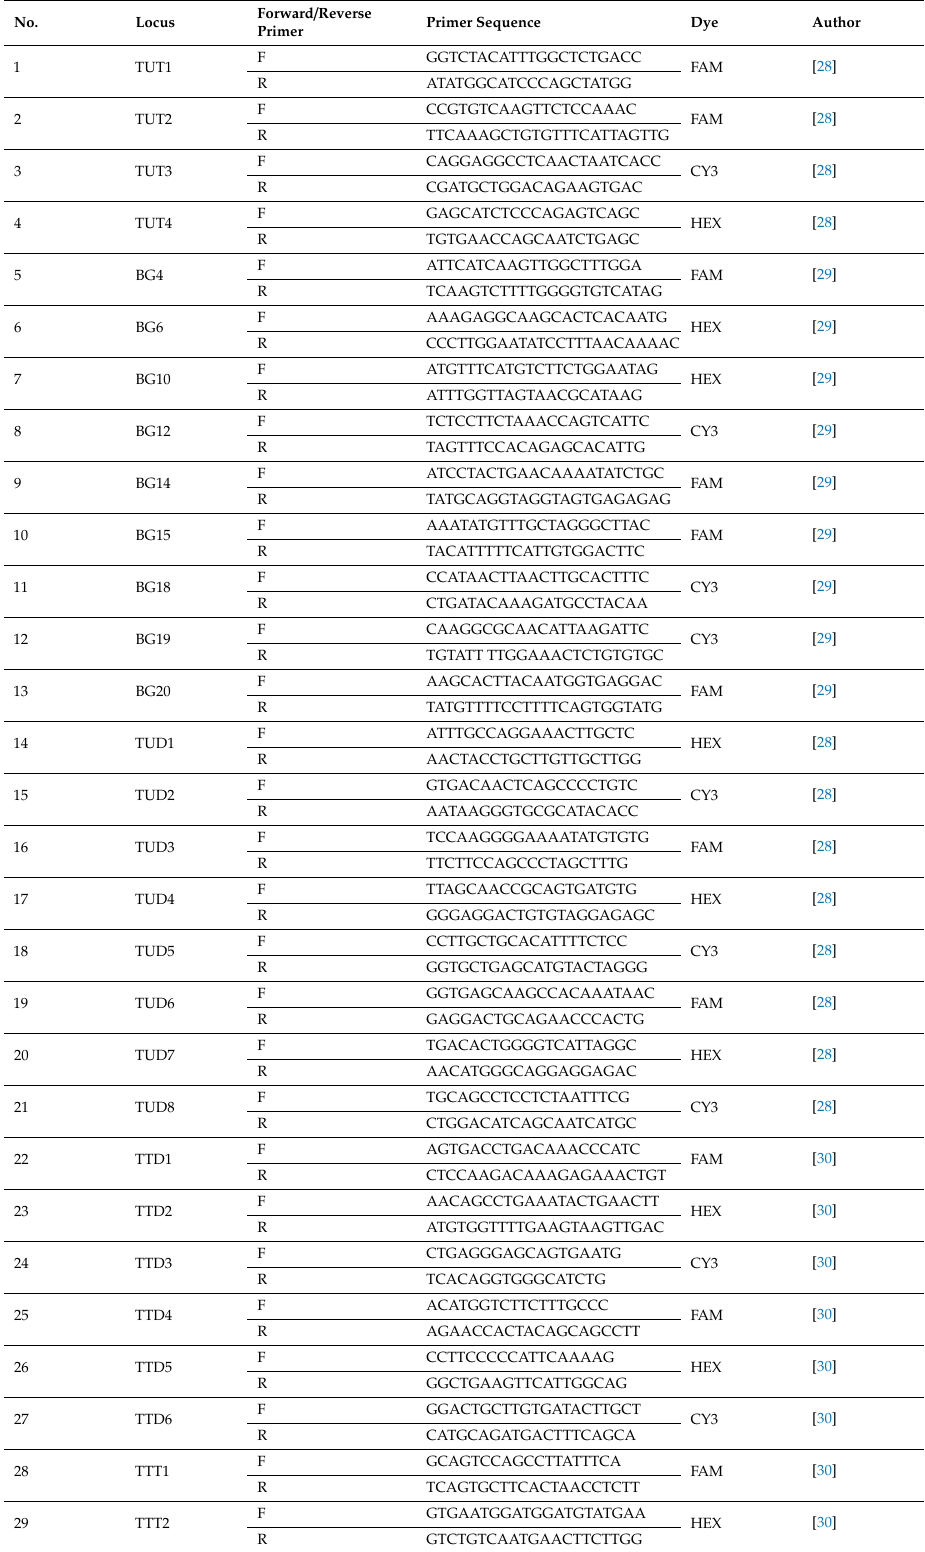
Table 2. The set of microsatellite loci used in this study, along with their primer sets, fluorescent dyes and